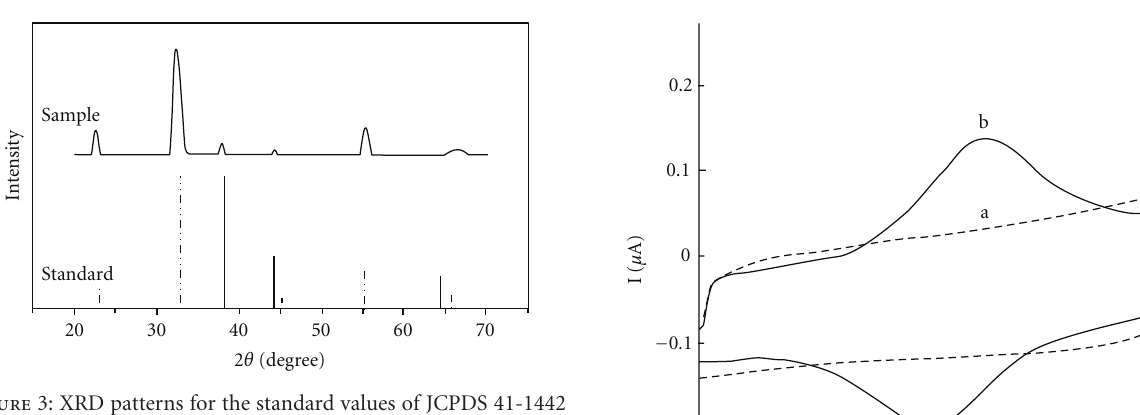
Figure 3: XRD patterns for the standard values of JCPDS 41-1442 (Mn 2 O 3 , dashed line), JCPDS 04-0783 (Ag, solid line), and the asprepared porous Mn 2 O 3 -Ag nanofibers.